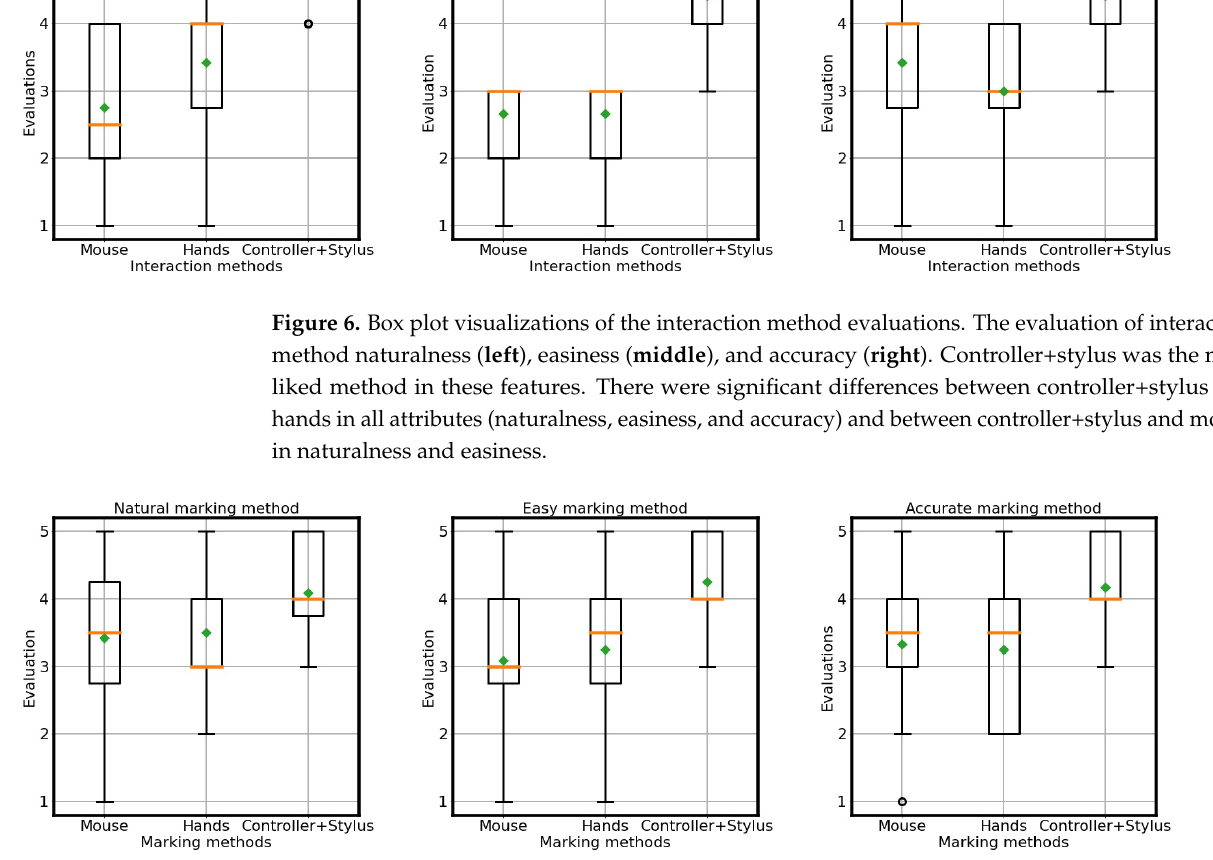
Figure 7. Box plot visualizations of the marking method evaluations. The evaluation of marking method naturalness ( left ), easiness ( middle ), and accuracy ( right ). Median values in these fea- tures are rather similar, and significant difference was found only in marking easiness between controller+stylus and